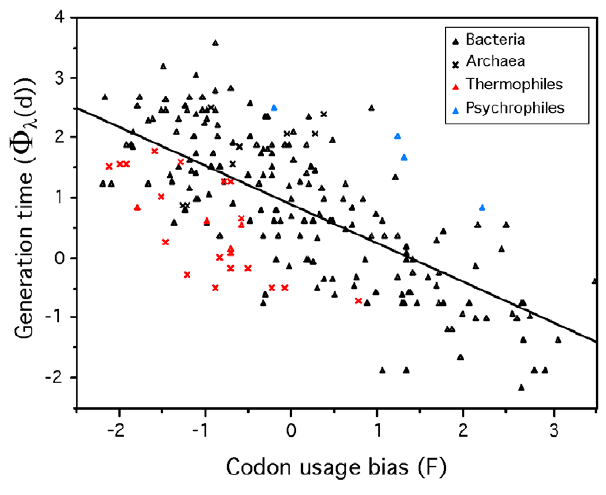
Figure 3. Minimum generation time (d) versus codon usage bias for 214 prokaryotes. F (first principal component of D ENC 9 and S) and W l (d) (Box-Cox transform of d) are negatively correlated ( r = 2 0.66). Line fitted by least squares regression: W l (d)=0.8741 2 0.6496 F (R 2 =0.47,